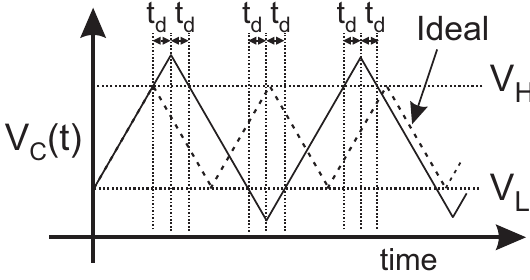
Figure 2. Influence of the delay in the output